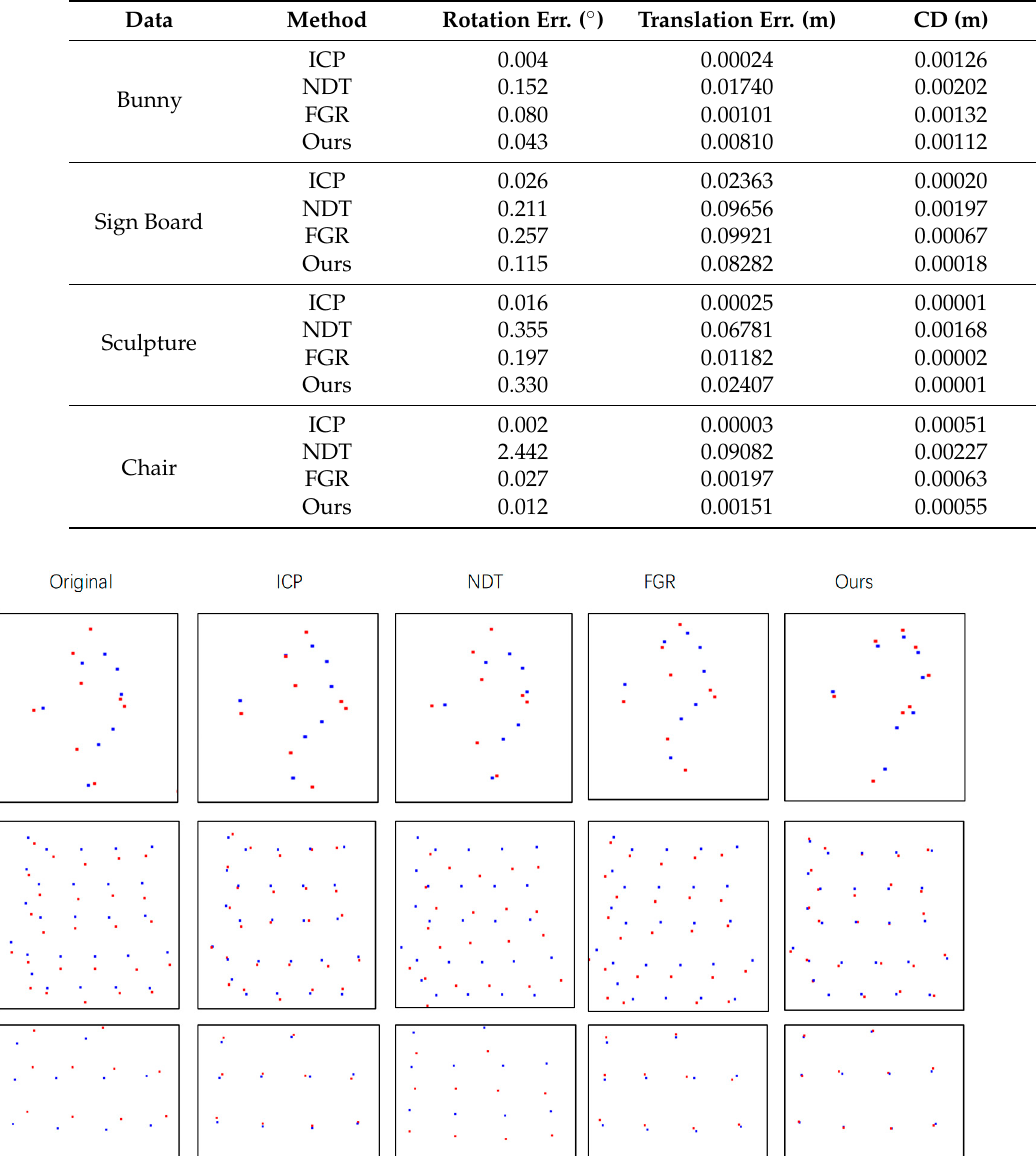
Table 3. Performance on Gaussian Noise Data.